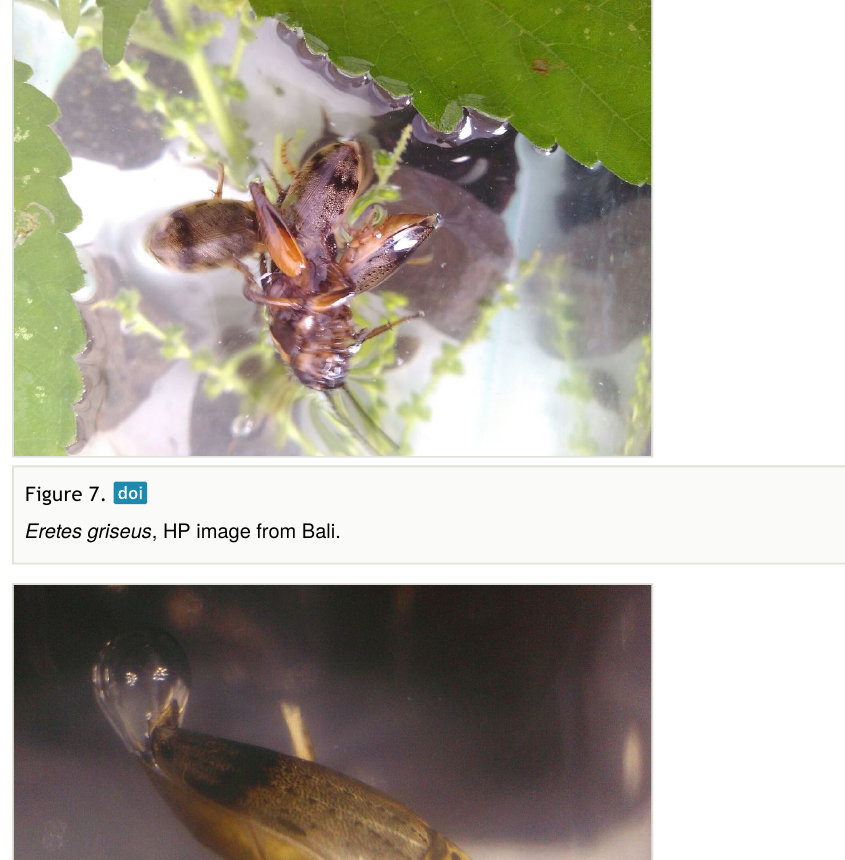
Figure 8. Eretes griseus , foto of Balinese specimen kept in